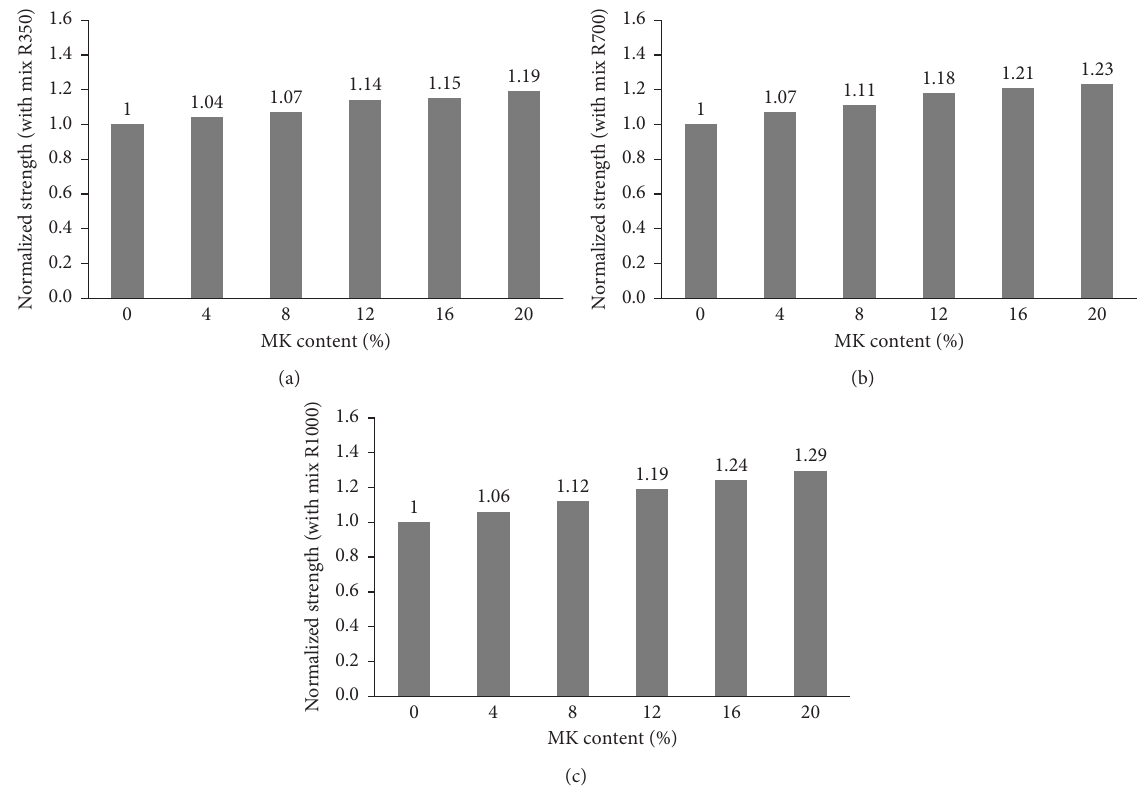
Figure 10: Normalized strength (with the mix of RCA without MK) for mixes. (a) RCA � 35%. (b) RCA � 70%. (c) RCA � 100%.